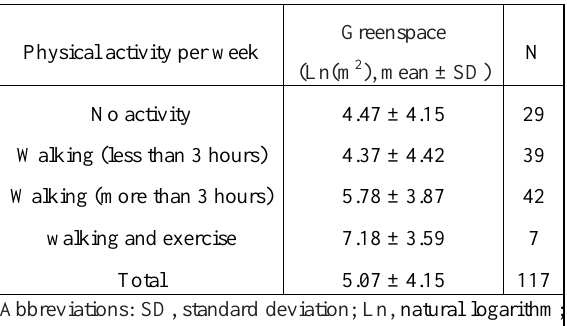
Table 4. Comparing means of greenspace in physical activity groups in follow-up